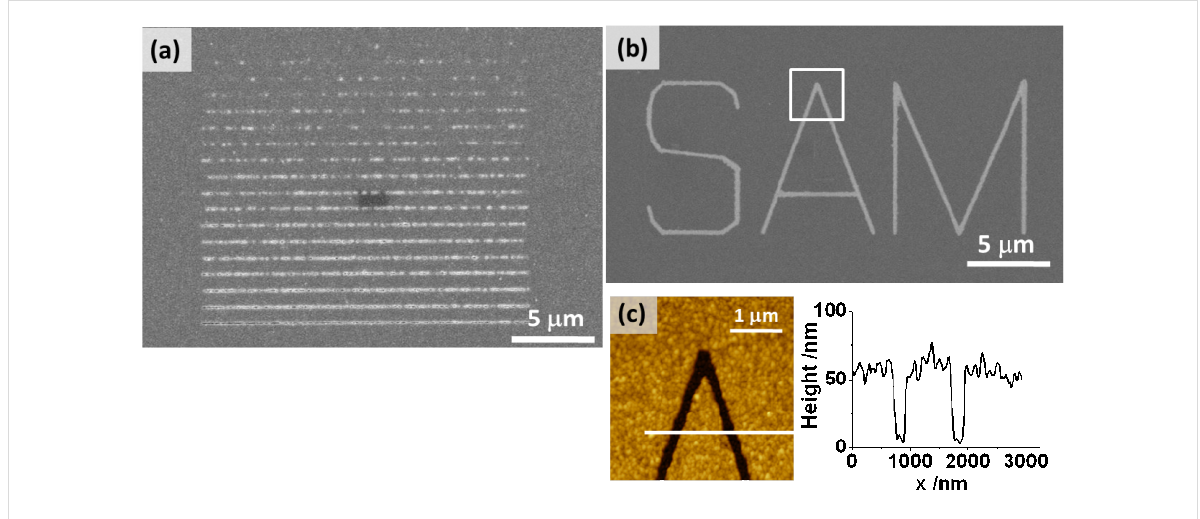
Figure 6: Electrochemical deposition of Cu on e-beam-patterned MBP0-SAM/Au/Si. (a) SEM image of a series of passivating lines written at different doses. The difference in the dose between lines is 25 mC/cm 2 , with 750 mC/cm 2 as the highest dose for the bottom line. (b) SEM image of “SAM” written with an electron beam at a dose of 1000 mC/cm 2 . (c) AFM image of the area marked by the square in (b) together with a height profile along the line. Deposition conditions: − 0.7 V for 1 s, − 0.25 V for 20 s (a); − 0.7 V for 1 s, − 0.35 V for 10 s (b).